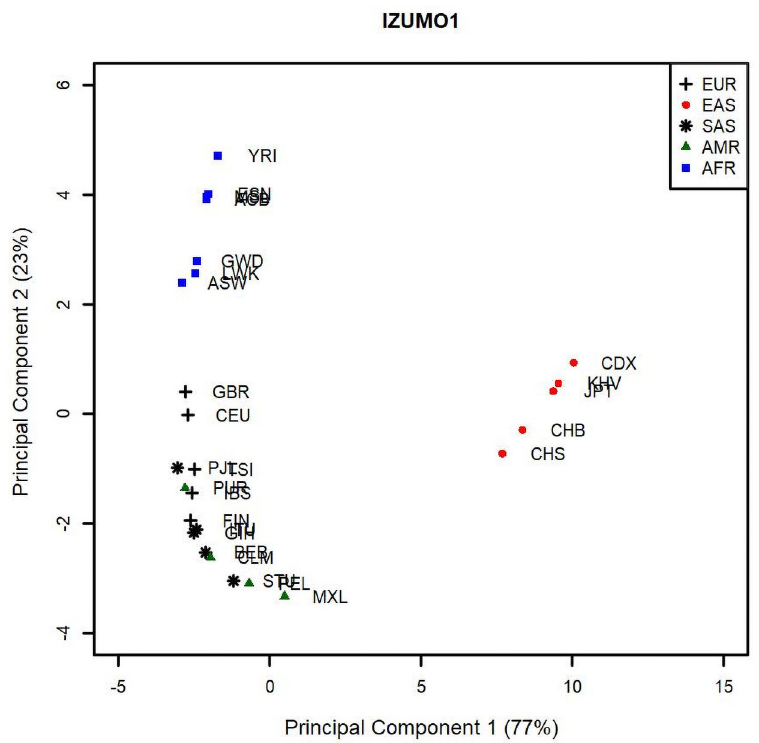
Fig 7. Principal component analysis of the F ST values for the IZUMO1 gene between 26 population groups that constitute the supergroups AFR (square), EUR (cross), EAS (circle), AMR (triangle), and SAS (star). The percentages between parentheses correspond to the variance carried by each PC. EAS and AFR segregate from the other 3 population groups.